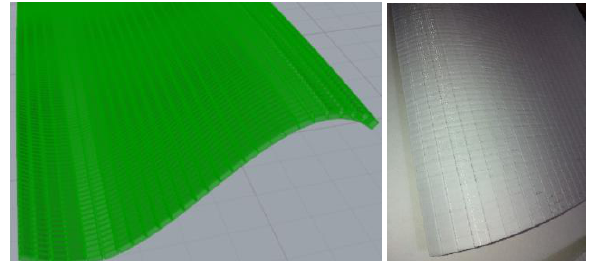
Figure 15: The digital model resulting from Grasshopper © script (left) allowed for the digital fabrication of four pieces of the roof surface of the Seaport Deposit of Montevideo in a scale of 1:30. This scale provides the possibility of verifying of the bricklaying in each of the four printed pieces (right).